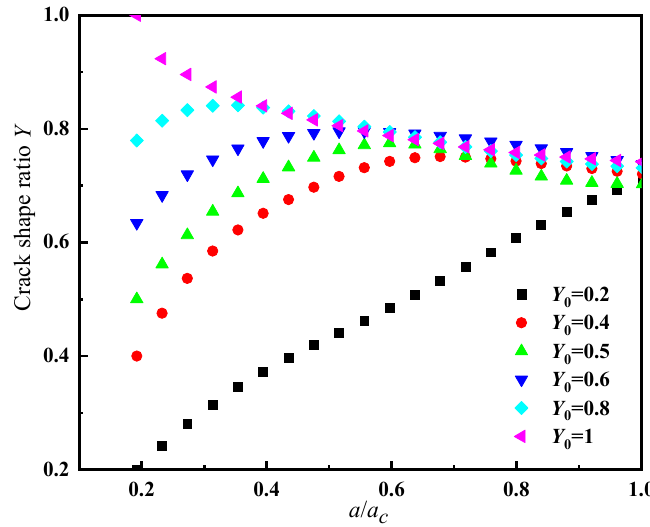
Figure 8. The changing trend of shape ratio during initial semi-elliptical surface crack growth.